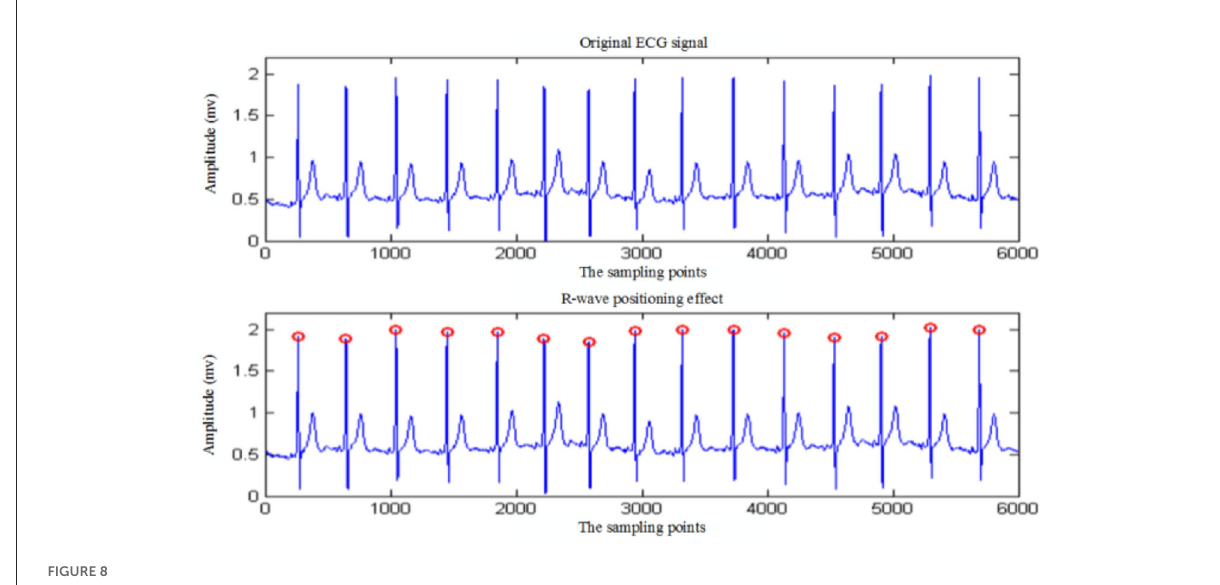
FIGURE8 R-wave detection of ECG signal without noise interference.